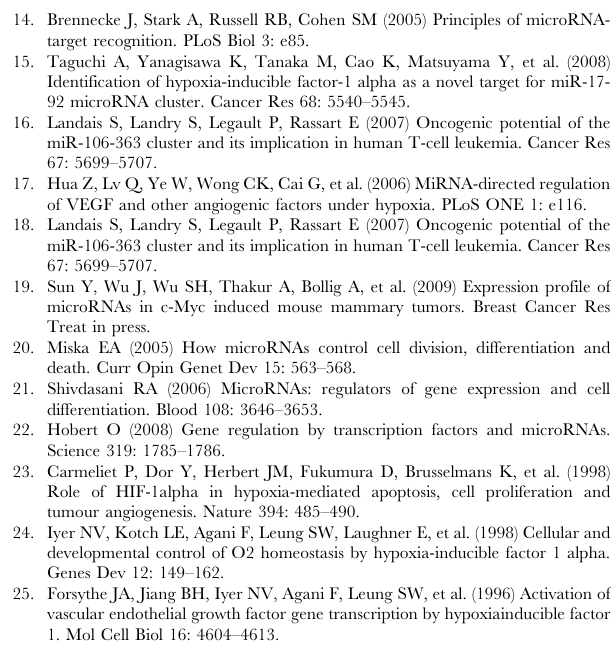
Figure S1 The expressions of miR-18a, 155 and 199b are not affected by different oxygen concentrations. The H22 and B16